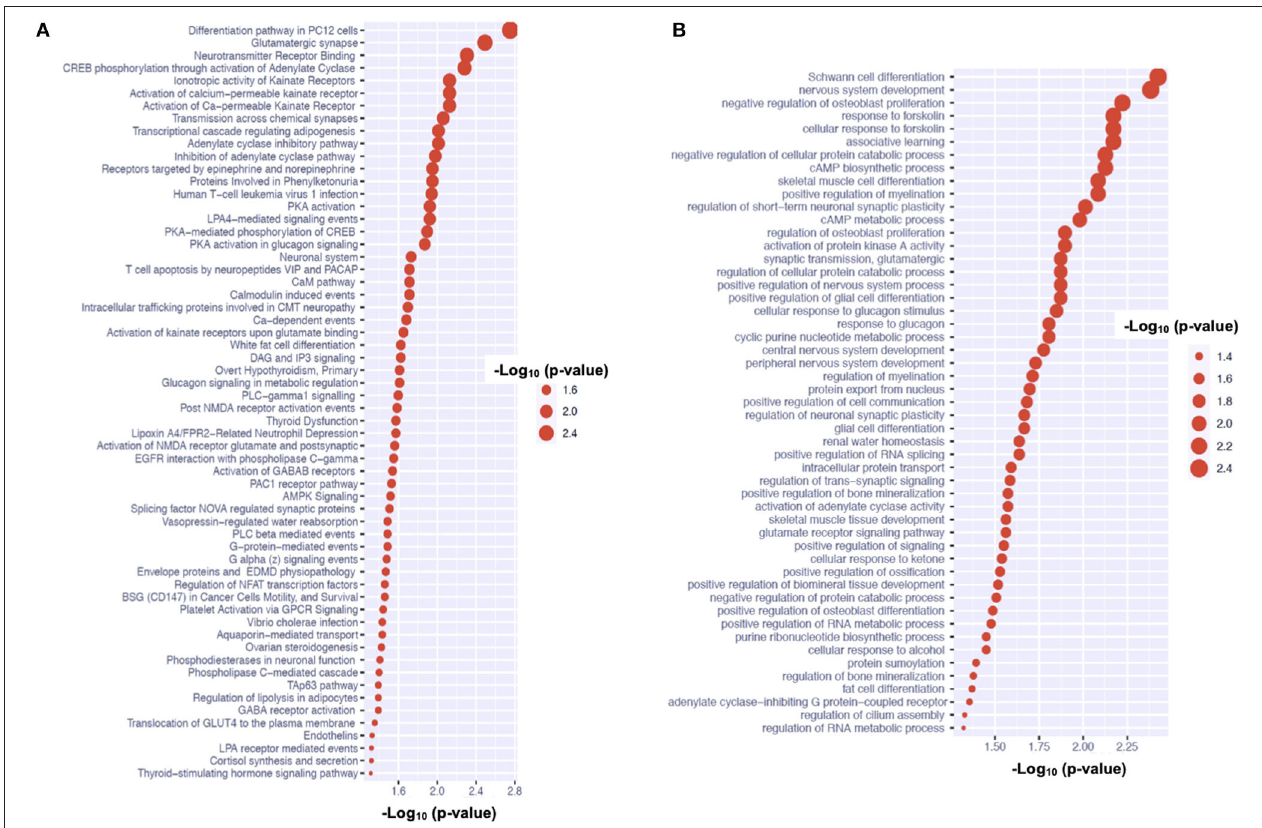
FIGURE 4 | Pathway analysis for candidate genes associated with urine 6-SM levels in children on the autism spectrum. (A) Shows the GO pathways over-represented by the genes associated with the 6-SM level. (B) Shows the signaling pathways over-represented by the genes associated with the 6-SM